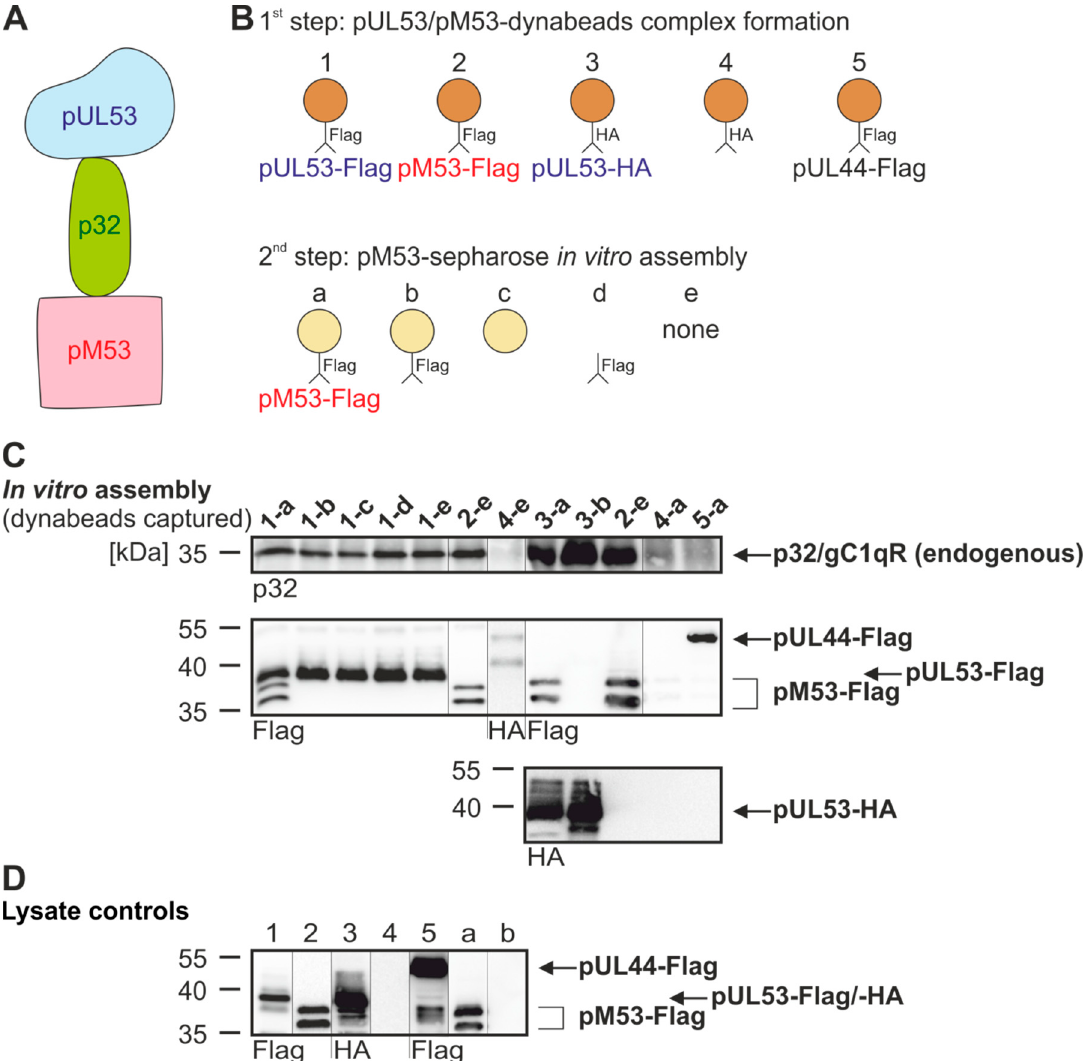
Figure 5. Assembly-based CoIP for interaction of pUL53, pM53 and p32 / gC1qR. ( A ) Complex formation of pUL53 and pM53 bridged by p32 / gC1qR. ( B ) Schematic overview of the performed experiment. In a first step, pUL53 or pM53 (or pUL44 as a negative control) formed complexes with p32 / gC1qR and was immunoprecipitated using dynabeads. In a second step, pM53 was immunoprecipitated with sepharose beads. ( C ) 293T cells were transiently transfected with HA-tagged pUL53, Flag-tagged pUL53, pM53 or pUL44. At two d p.t., cells were lysed and Flag-tagged pUL53, pM53, pUL44 or HA-tagged pUL53 was immunoprecipitated using mAb-Flag or -HA / dynabeads (orange), whereas pM53 was also immunoprecipitated using mAb-Flag / sepharose beads (yellow). Subsequently, settings 1–5 were incubated under the following conditions of CoIP overnight: (a) pM53-Flag immunoprecipitated by sepharose beads, (b) mAb-Flag linked to sepharose beads, (c) sepharose beads alone, (d) mAb-Flag alone or (e) none of these. Thereafter, dynabeads were separated and subjected to standard Wb analysis using tag- or protein-specific antibodies as indicated. ( D ) Lysate controls were taken prior to the IP, analyzed and immunostained by SDS-PAGE / Wb as indicated.